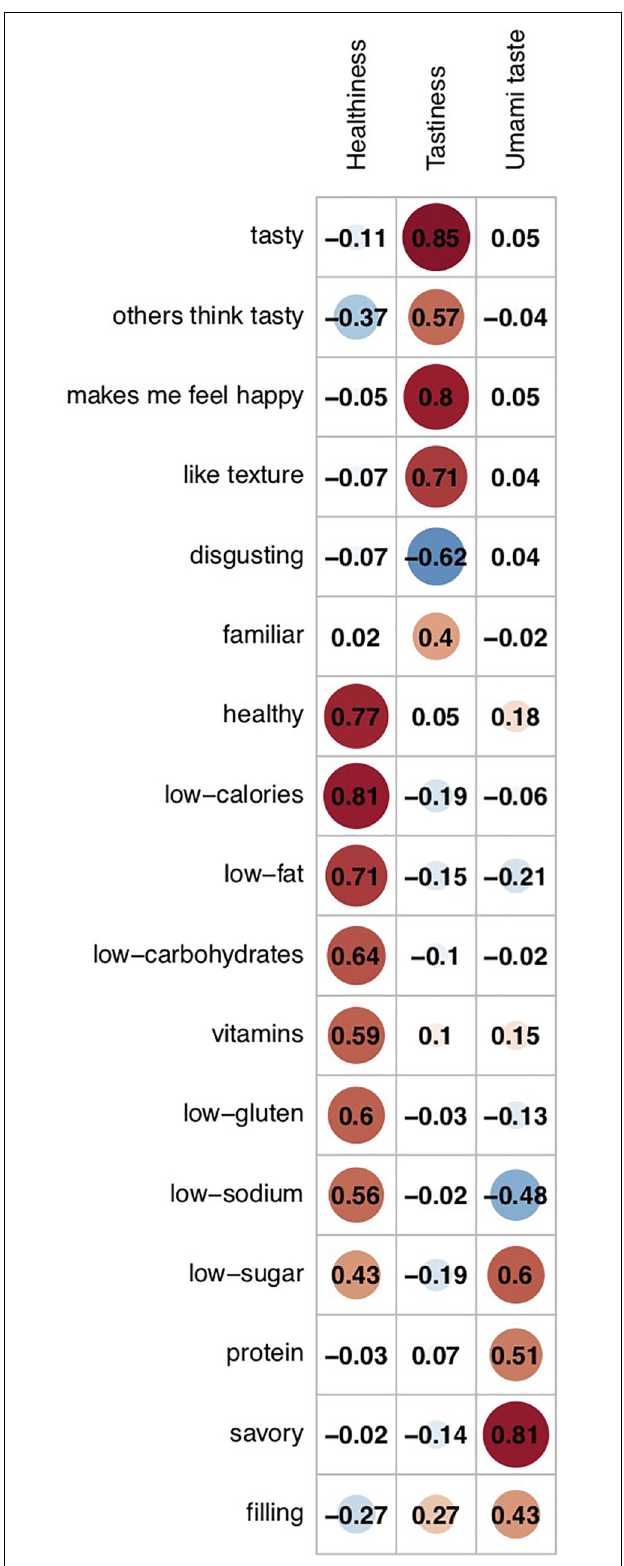
FIGURE 7 | Loadings of rating attributes on the three latent factors. Ratings for calories, fat, carbohydrates, gluten, sodium, and sugar were reversed so that higher ratings indicated lower content of these nutrients. The corresponding attributes were relabeled accordingly (e.g., calories became low calories). Factor 1 was labeled as Healthiness given positive loadings from low-calorie, low-carbohydrate, low-fat, low-gluten, and low-sodium content ratings, and positive loadings from healthiness and vitamin content ratings. Factor 2 was labeled Tastiness based on positive loadings from ratings of tastiness, estimates of others’ tastiness evaluations, favorable texture, feelings of happiness evoked from the food, and negative loadings from disgust ratings. Factor 3 was labeled as an umami taste factor, given the positive loading of savoriness ratings, and (to a lesser extent) ratings of protein and low-sugar